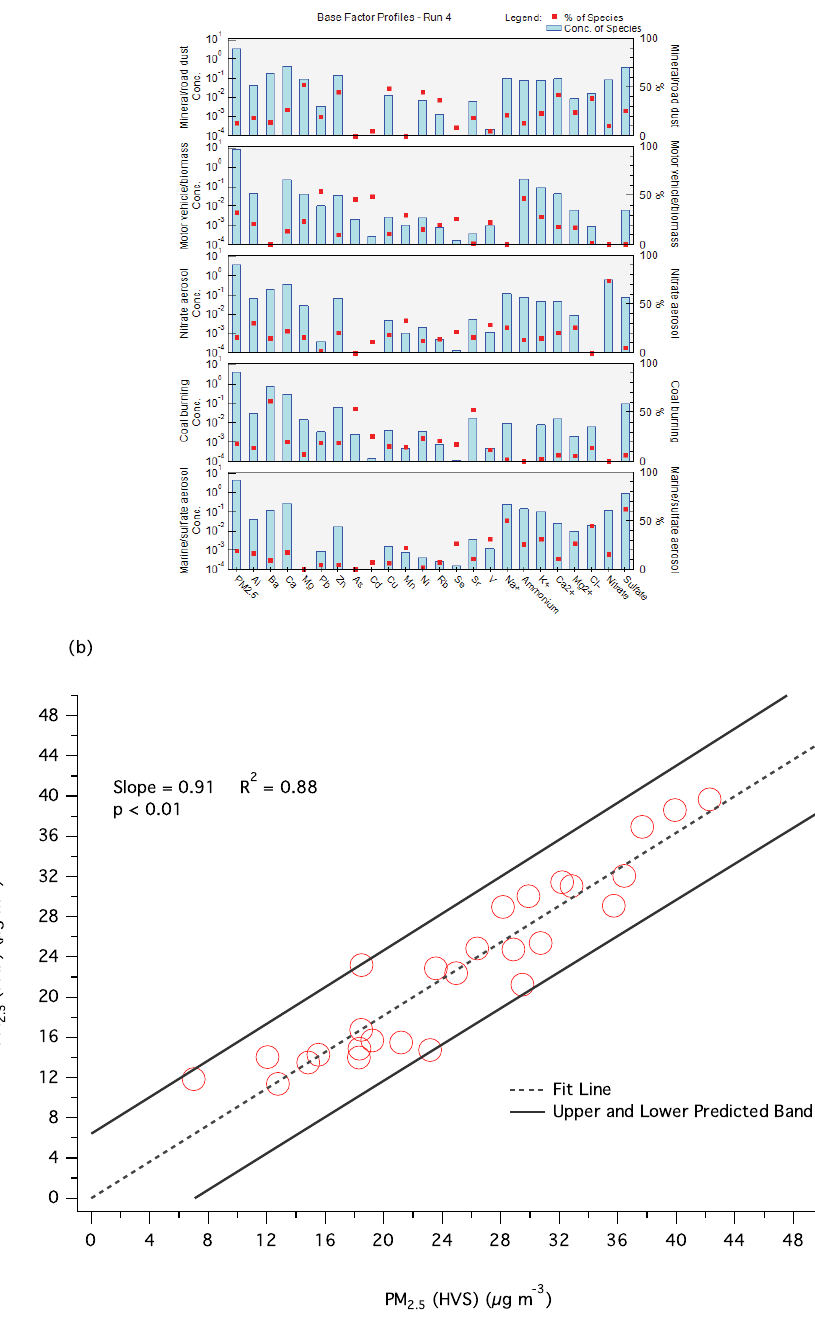
Figure 6. (a) The source profiles of PM 2 . 5 by positive matrix factorization model and (b) comparison of PM 2 . 5 (PMF) and PM 2 . 5 (HVS).